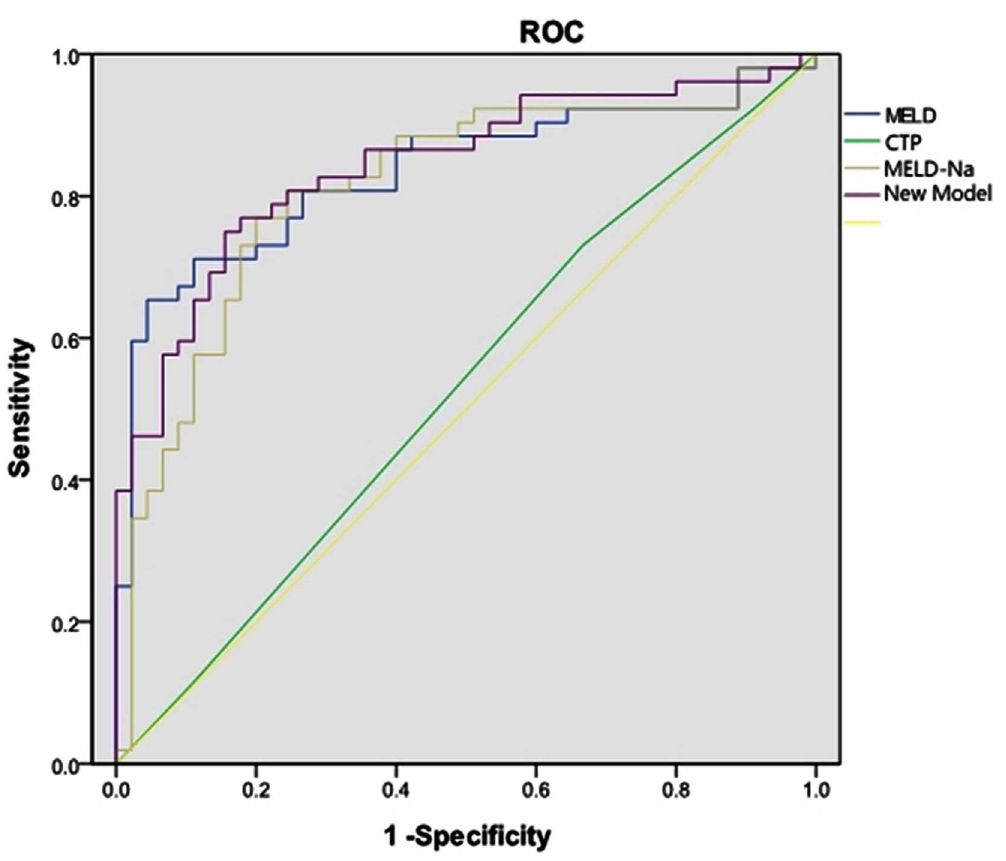
Figure 5. ROC curves of the new model versus CTP, the original MELD scoring system, and MELD-Na scoring systems as predictors of 12 weeks mortality in the validation cohort. The area under ROC curve (95% CI) of the new model, CTP, MELD and MELD-Na scoring systems were 0.84 (0.76–0.92), 0.53 (0.41–0.65), 0.83 (0.75–0.91) and 0.81 (0.72–0.90) respectively.